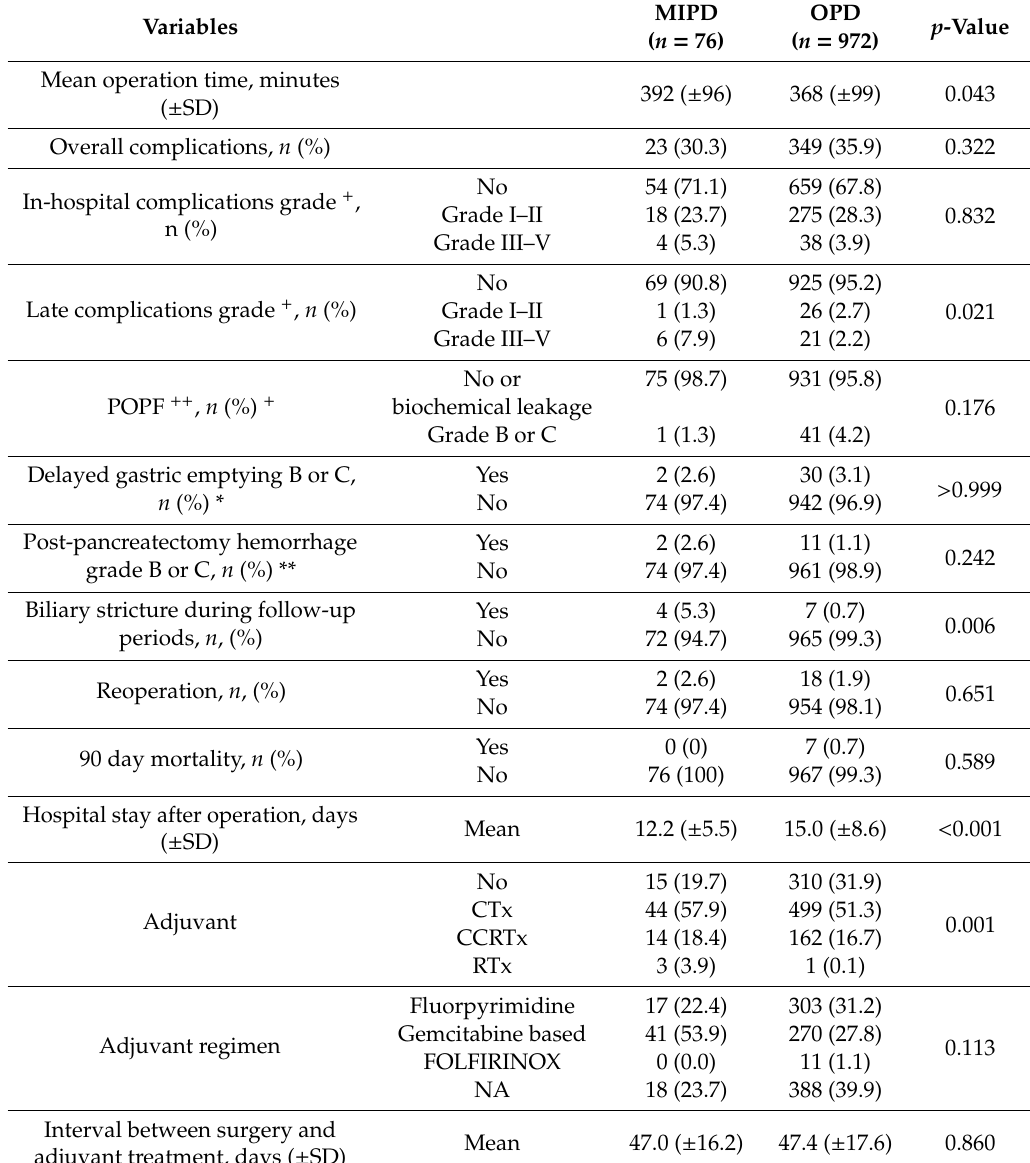
Table 2. Perioperative outcome according to method of